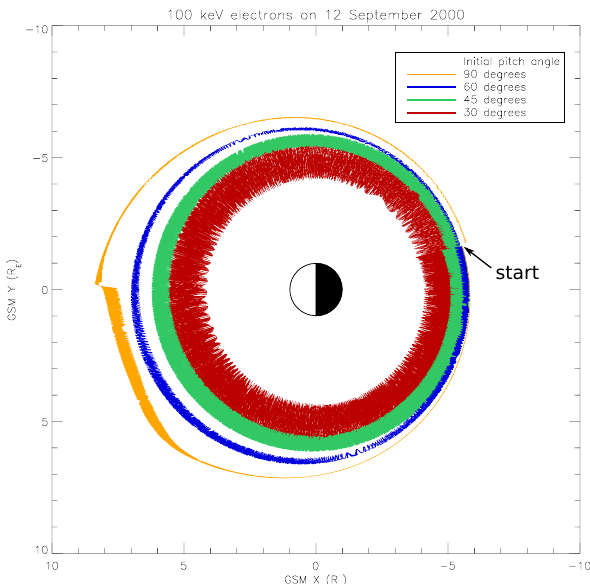
Fig. 7. The differential drift paths of electrons with four different pitch angles are shown. All simulations begin at the location of Po- lar at 06:00UT and trace backwards in time until the particle is lost or completes a drift orbit. All four particles drifted around from lo- cal noon indicating stably trapped drift orbits.